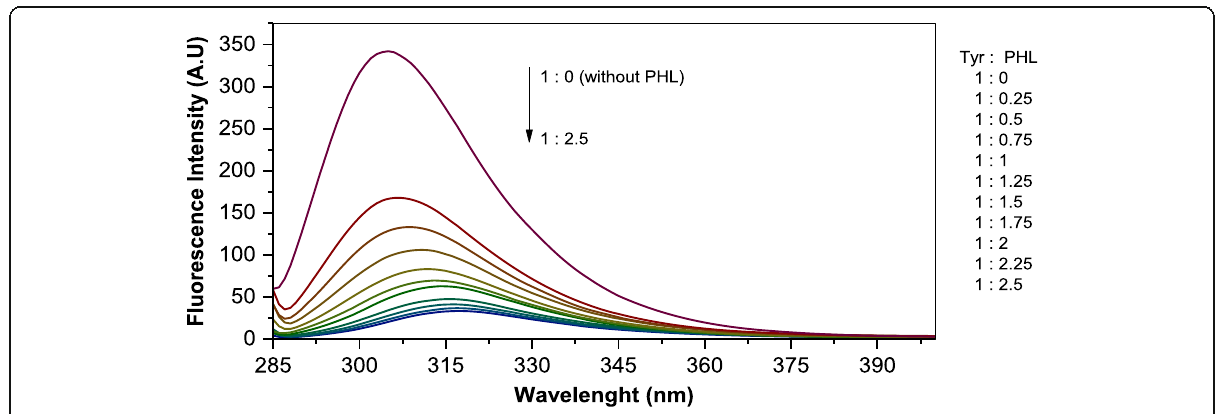
Fig. 7 The fluorescence intensity of Tyr by PHL in